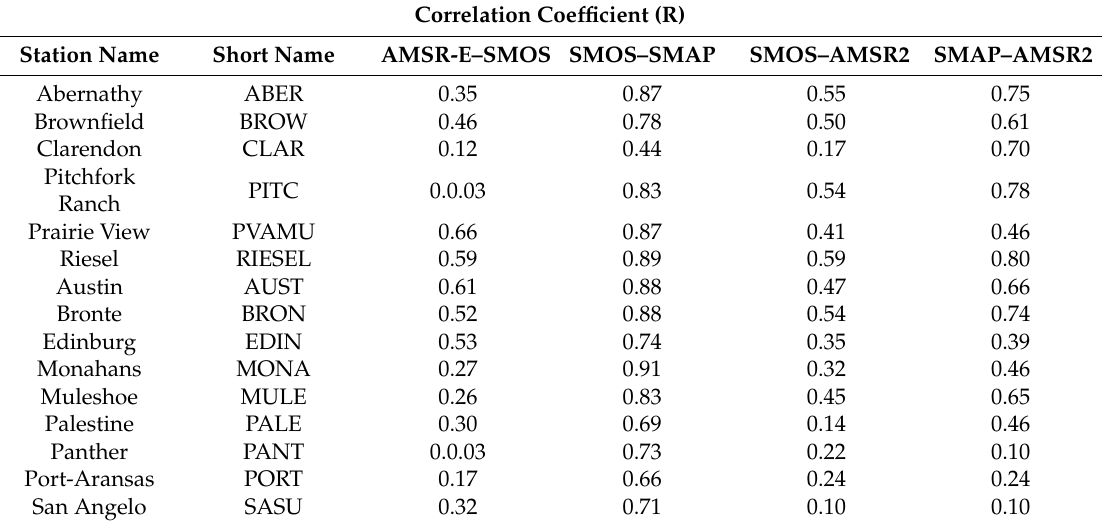
Table 4. Correlations among satellite soil moisture observations during their overlapping periods (state of